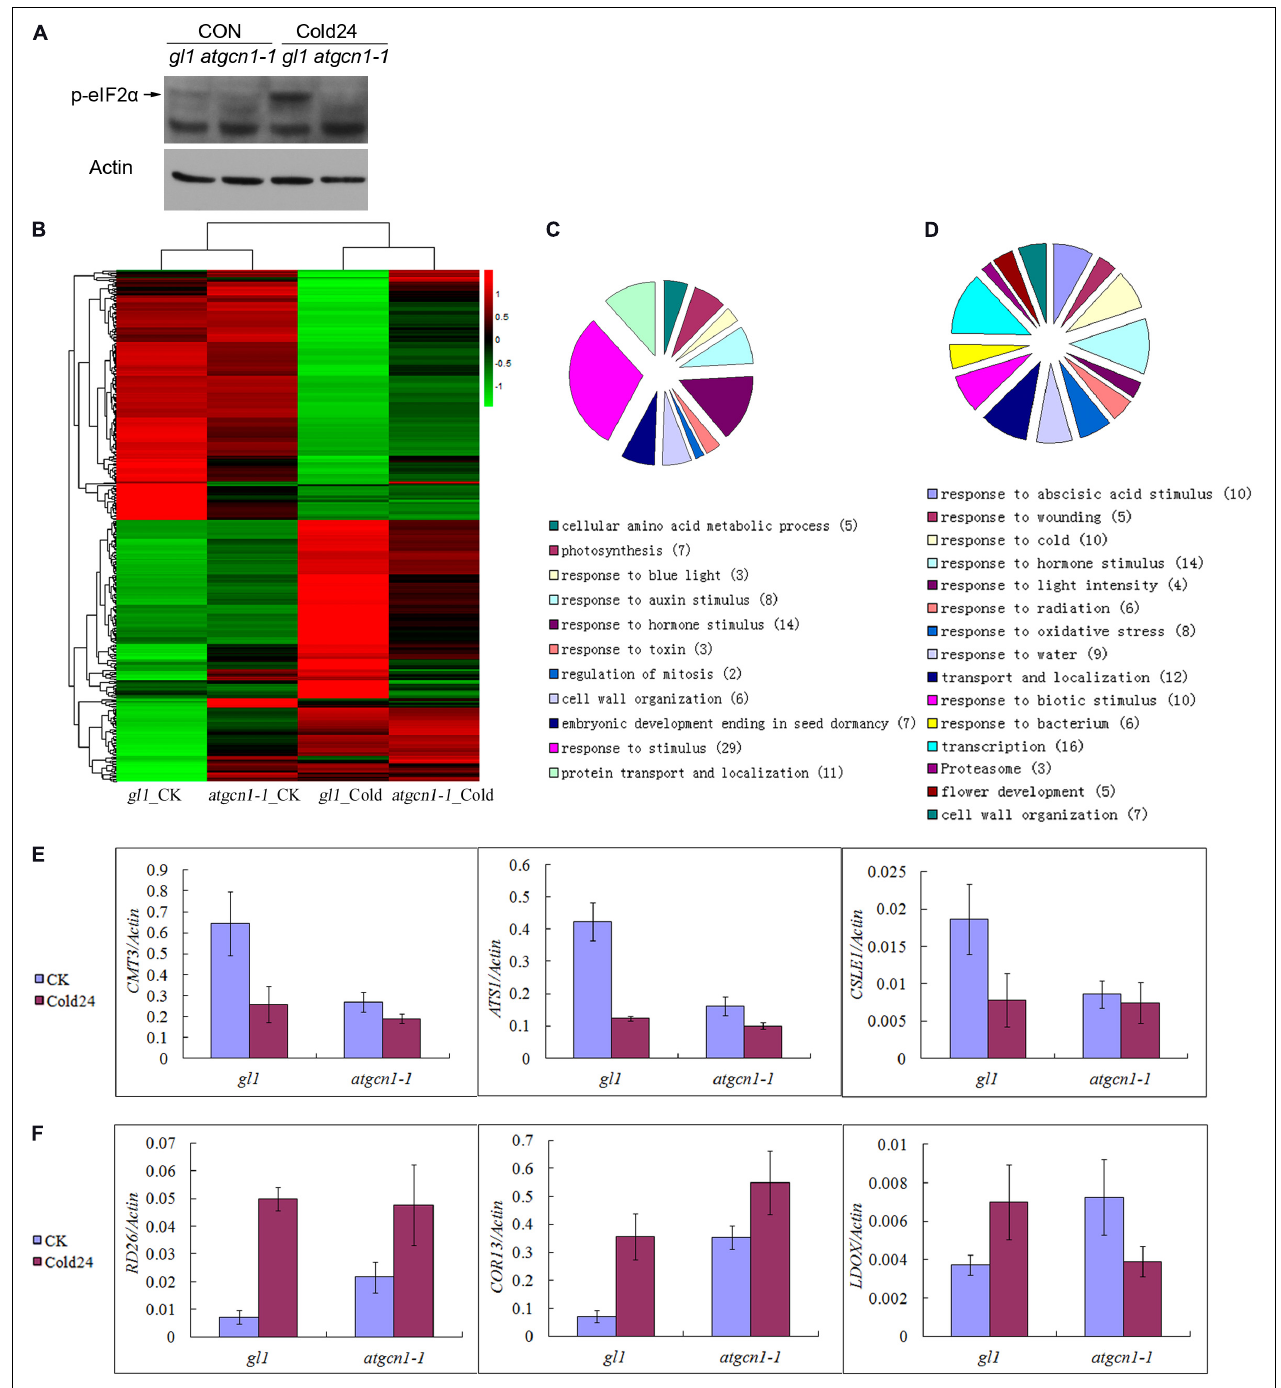
FIGURE 3 | eIF2 α phosphorylation selectively regulates gene transcription under cold stress conditions. (A) The immunoblotting assays of antibodies against phosphorylated eIF2 α under normal temperature and cold stress conditions. Western blot results with Actin used as a control. (B) Hierarchical clustering analysis of cold-ATGCN1 genes at transcriptional levels. (C) GO terms analysis of cold-ATGCN1 down-regulated genes at transcriptional levels. (D) GO terms analysis of cold-ATGCN1 up-regulated genes at transcriptional levels. (E) Cold-ATGCN1 down-regulated genes selected for validation by using qRT-PCR. (F) Cold-ATGCN1 up-regulated genes selected for validation by using qRT-PCR. CK, grown in normal temperature conditions. Cold or Cold24, treated by cold stress conditions of 4 ◦ C temperature for 24 h treatment. qRT-PCR was repeated three times with similar results attained.